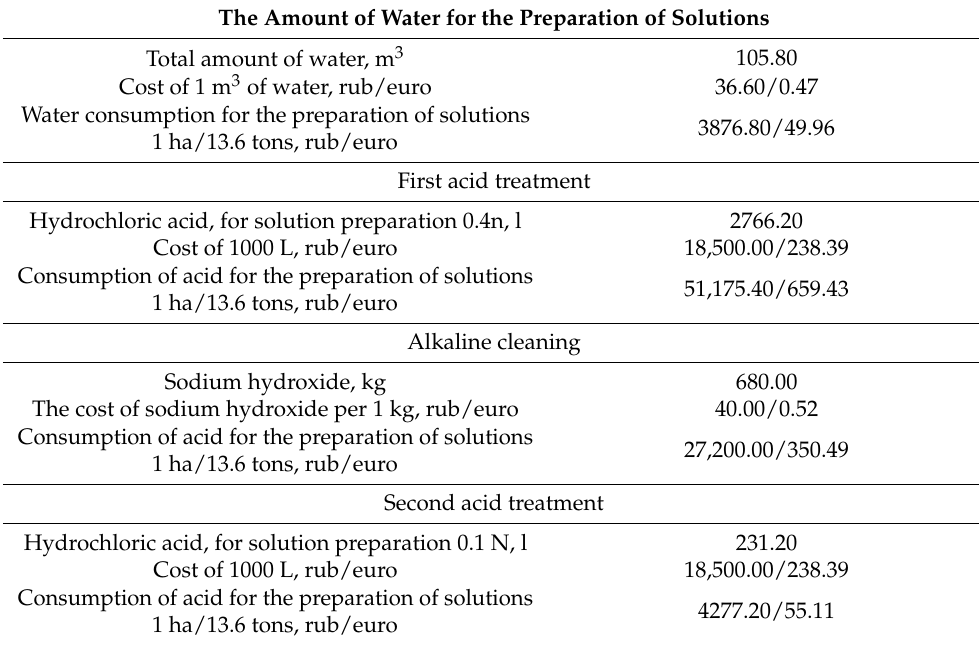
Table 5. The prime cost of pulp from harvesting hogweed from a field of one